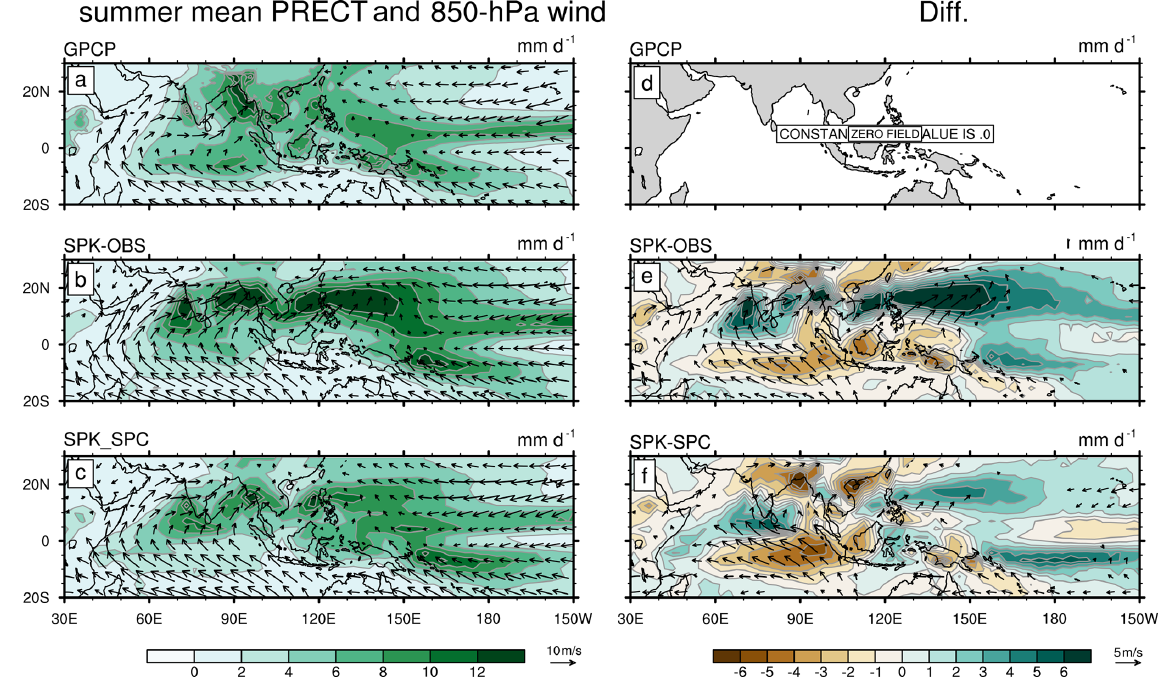
Figure 2. May–October mean precipitation (shading) and 850hPa wind (vector; with amplitude > 3.5ms − 1 ) for (a) GPCP precipitation and ERAI 850hPa wind, (b) SPK-OBS, and (c) SPK-SPC. Panels (e, f) are calculated differences between (b, c) and (a)